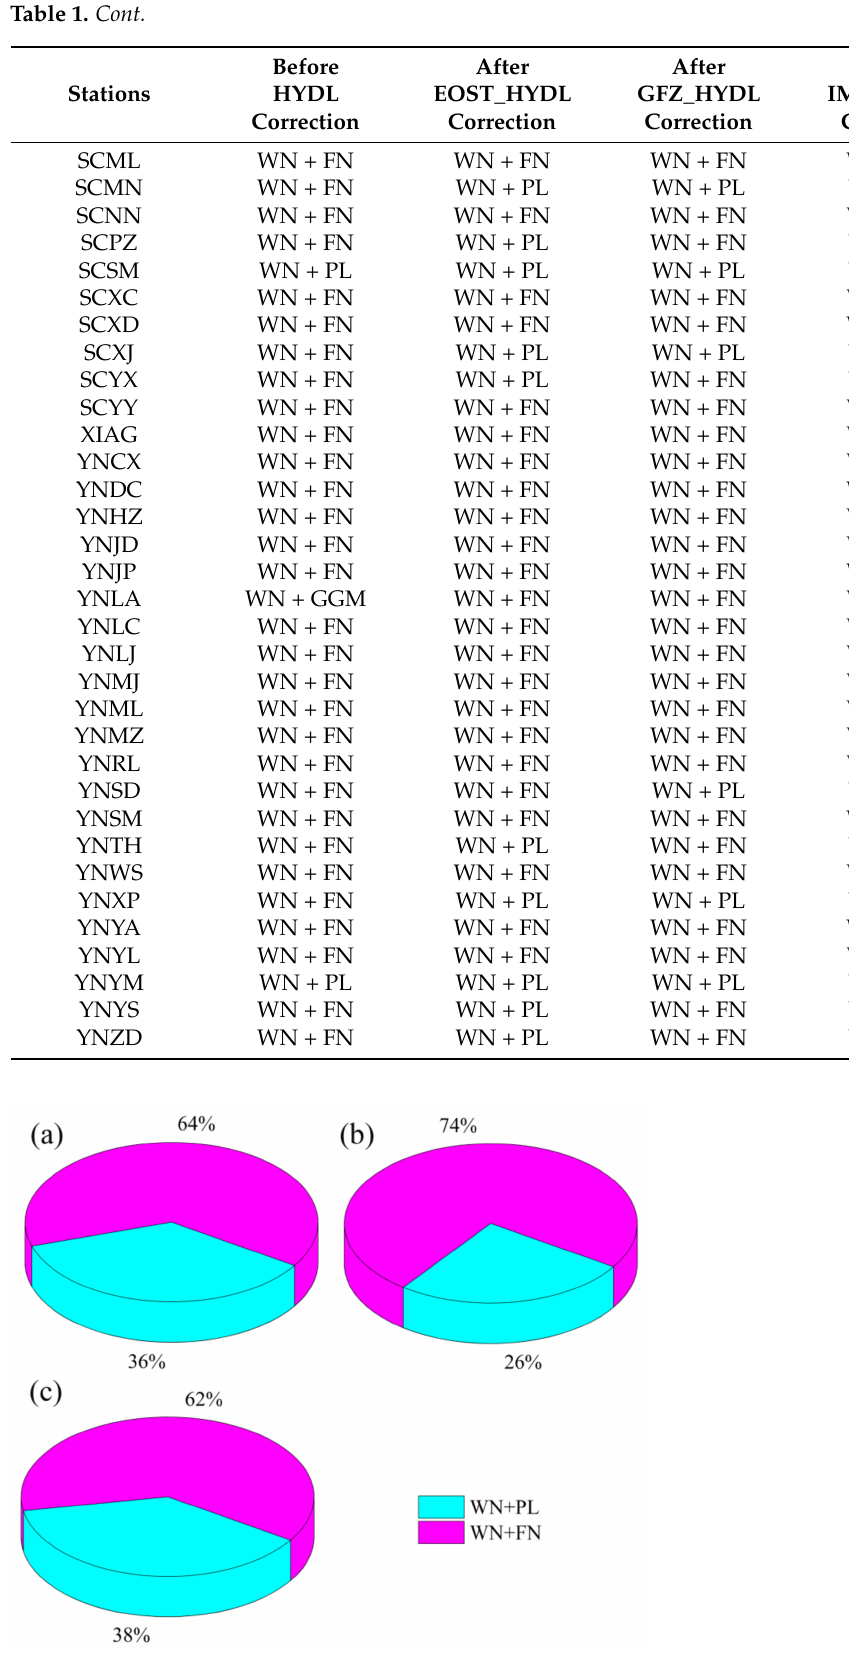
Figure 10. Distribution of optimal noise models after HYDL correction provided by EOST ( a ), GFZ ( b ), and IMLS ( c